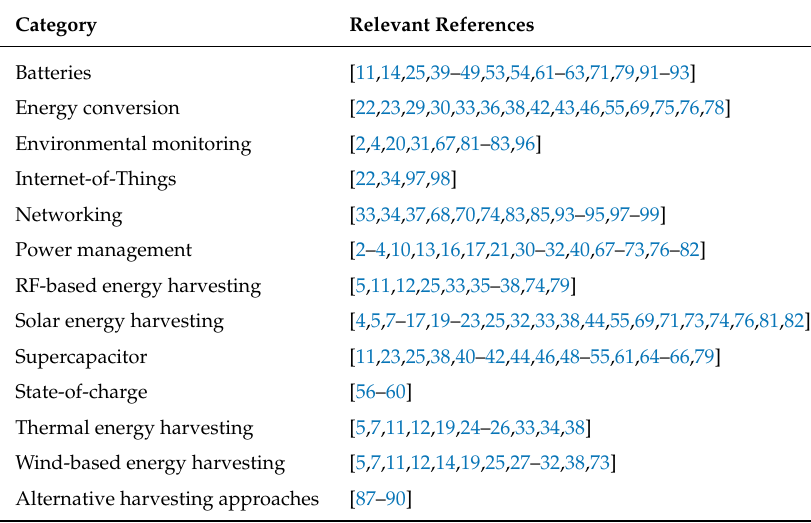
Table A1. Categorization of reviewed